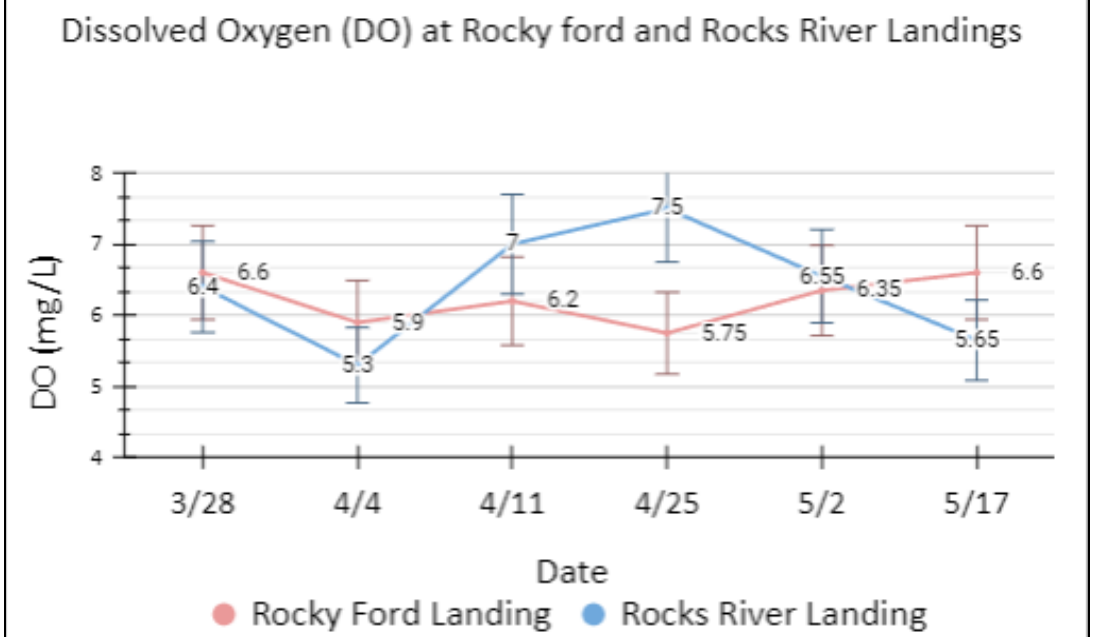
Figure 10. Water Quality — Dissolved Oxygen Level Measurements from March – May 2022.